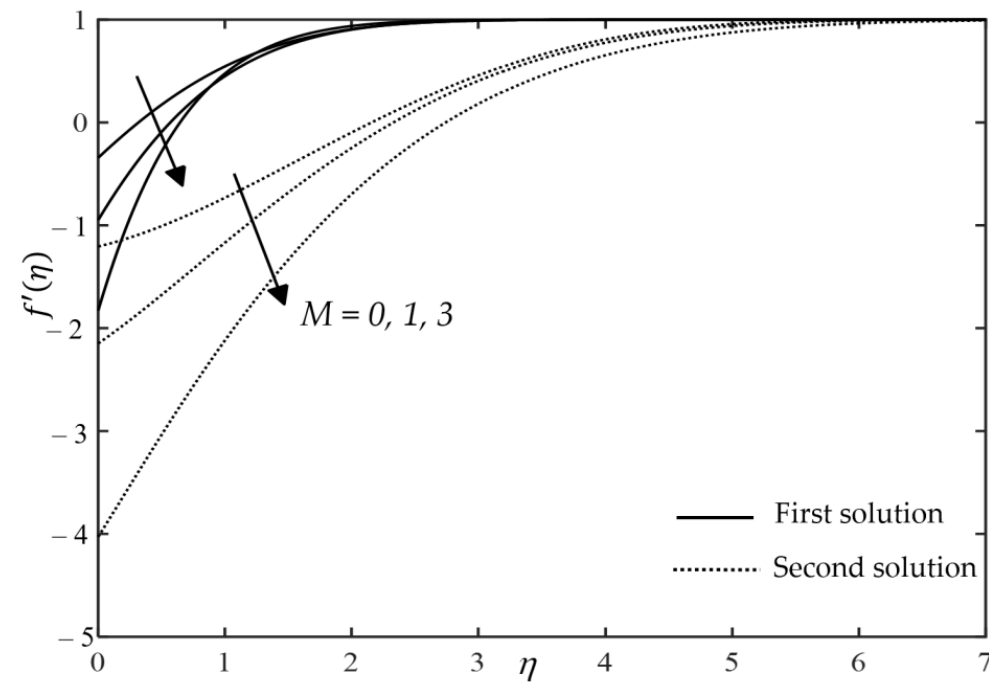
= 0.01, A = 1, κ = 1, and δ = 1.